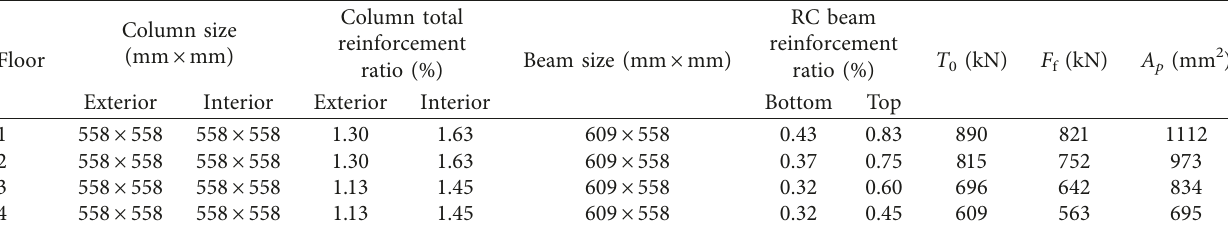
Table 1: Design characteristics of the RC and SC